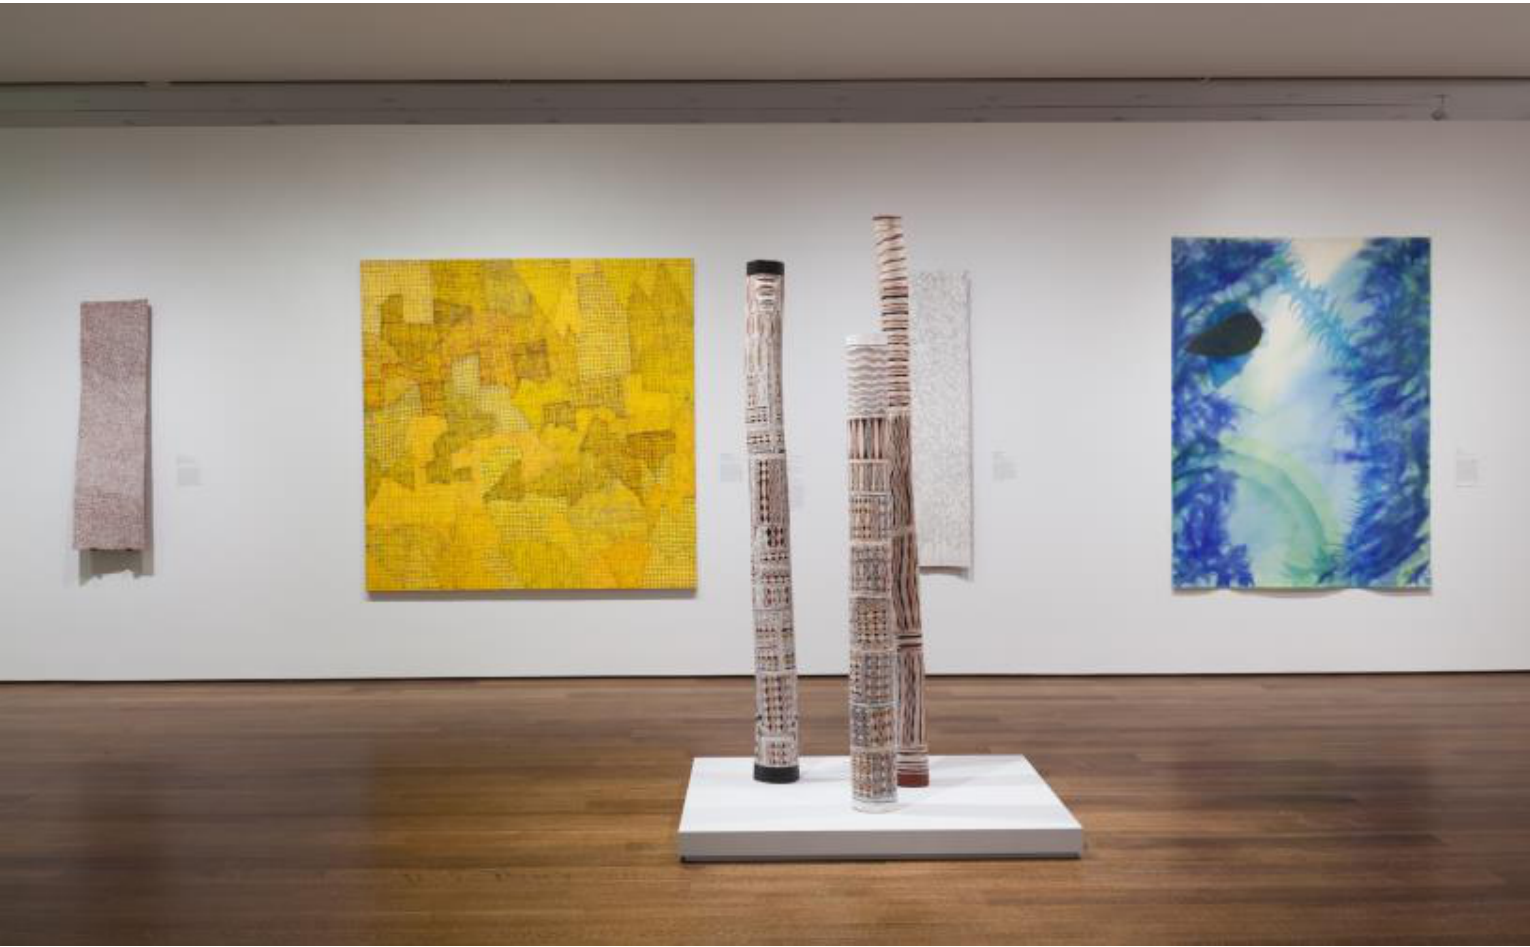
Installation view of “Seasonality” module from Everywhen: The Eternal Present in Indigenous Art from Australia, Harvard Art Museums, Cambridge, MA, curated by Stephen Gilchrist. Works left to right: Gulumbu Yunupingu, Garak IV (The Universe) , 2004; Regina Pilawuk Wilson, Syaw (Fish Net) , 2008; Yumutjin Wunungmurra, Gangan to Baraltja (larrakitj) , 2005; Djirrirra Wunungmurra, Dhalwangu (larrakitj) , 2005; Djambawa Marawili, Dhakandjali — Dhupundji (larrakitj) , 2006; Djirrirra Wunungmurra, Yukuwa , 2010; and Judy Watson, Bunya , 2011. Image Courtesy Harvard Art Museums, © President and Fellows of Harvard